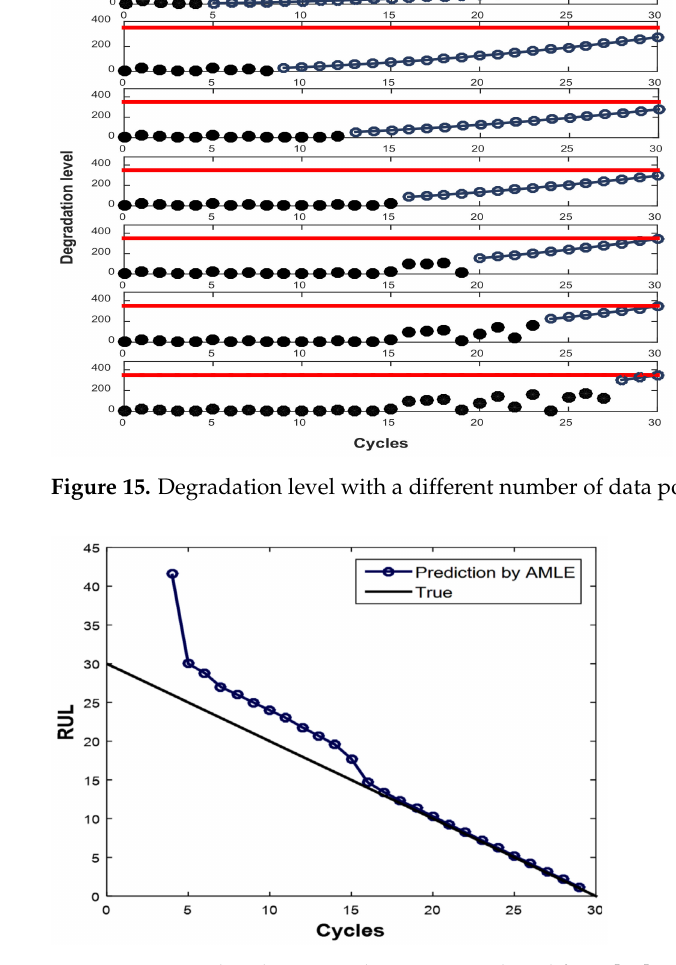
Figure 16. Actual and estimated RUL. Reproduced from [51],